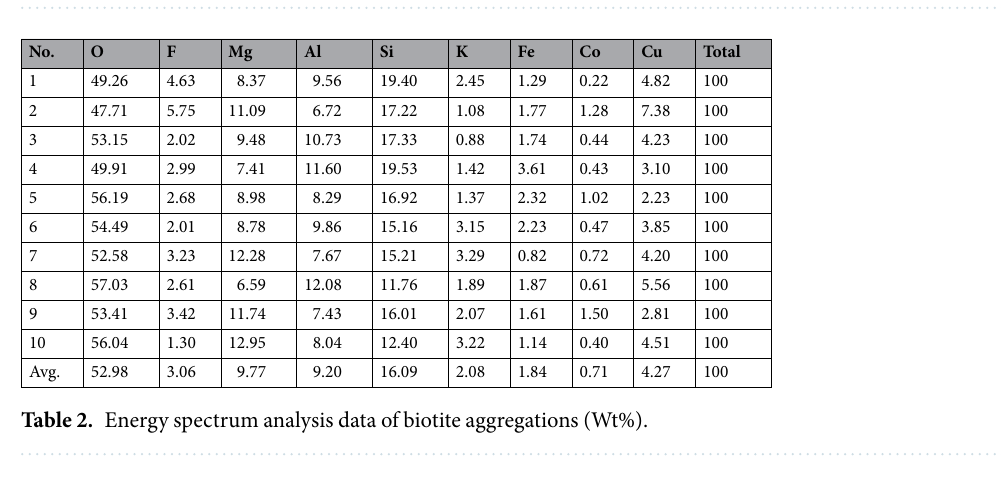
Table 1. Energy spectrum analysis data of monomeric biotite (Wt%).